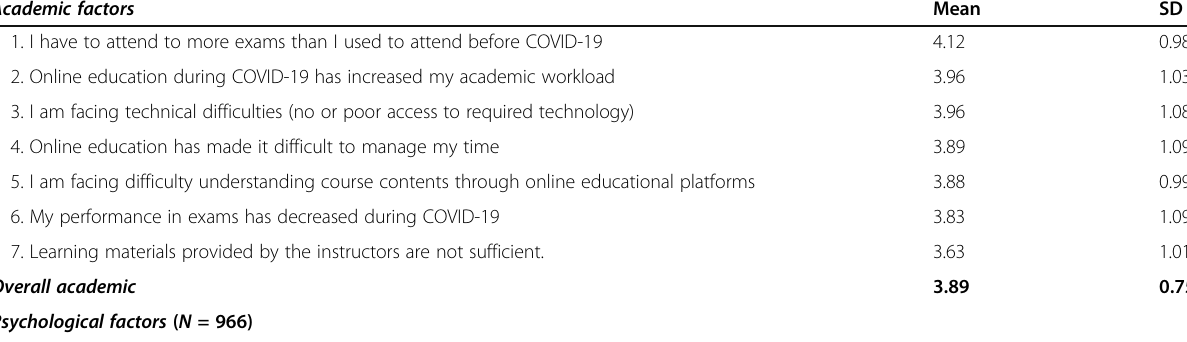
Table 4 Ranking of stress factors by mean ( N = 966) Academic